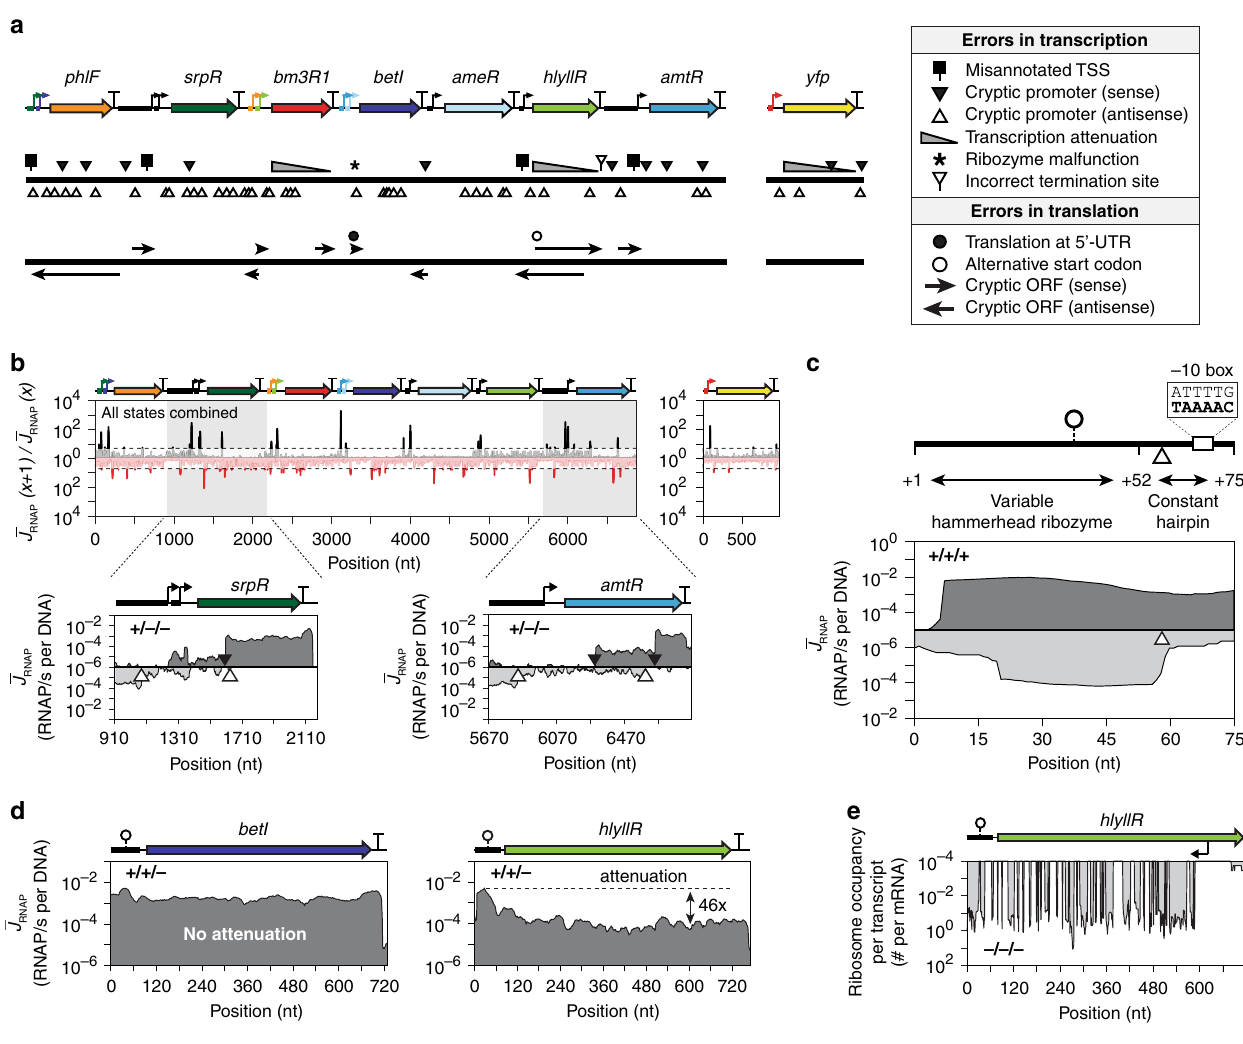
Fig. 2 Unexpected transcription and translation. a A summary of transcriptional (top) and translational (bottom) errors, with respect to the designed circuit, are shown. The size of the arrows are accurate to the length of the cryptic ORFs. b The detection of TSSs in the sense (top) and antisense (bottom) directions are shown. When the derivative of the pro fi le is larger than the cutoff required to mark a TSS (dashed lines), it is colored darker. The srpR and amtR transcription units are shown for state + / − / − (IPTG/aTc/Ara). The dark and light gray fi lled regions represent transcription on sense and antisense strands, respectively. Cryptic promoter positions are marked by fi lled (sense strand) and empty (antisense strand) triangles. c The riboJ53 insulator is shown, marking the unexpected TSS (white triangle) and − 10 σ 70 motif. The sense and antisense pro fi les are shown in dark and light gray, respectively. d The transcript pro fi les for the betI and hlyIIR transcription units is shown (state + / + / − ). The dashed line marks the height of the pro fi le at the beginning of the transcript to highlight attenuation. e The antisense cryptic promoter is marked and the antisense translation detected through ribosome pro fi ling is shown. Source data are provided as a Source Data fi